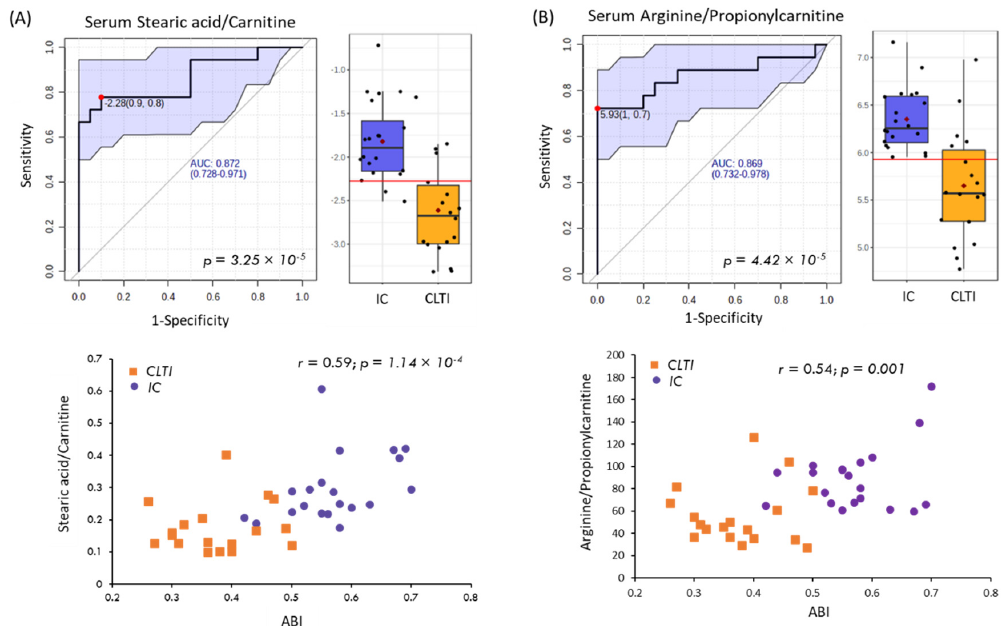
Figure 5. Upper panels show the receiver operating characteristic (ROC) curves and their corresponding box–whisker plots for the two top-ranked serum biomarker ratios used for discriminating chronic limb-threatening ischemia (CLTI, n = 18) from intermittent claudication (IC, n = 20) patients, including ( A ) stearic acid / carnitine (18:0 / C0) and ( B ) arginine / propionylcarnitine (Arg / C3). Ratiometric ROC curves depict the area under the curve ( AUC ) and their 95% confidence intervals (blue shaded area). Lower panels depict the linear relationship of the serum biomarkers of PAD disease progression as a function of abnormal ankle–brachial index (ABI < 0.90) measurements with moderately strong Pearson correlation coefficients ( r > 0.50; p < 0.002).